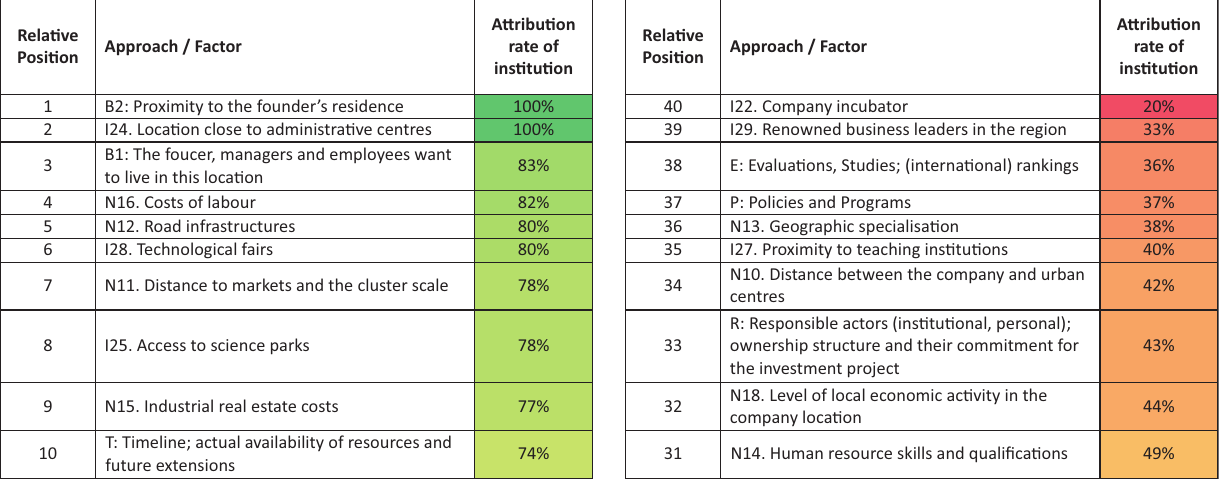
Figure 10. Evaluation output of fictional